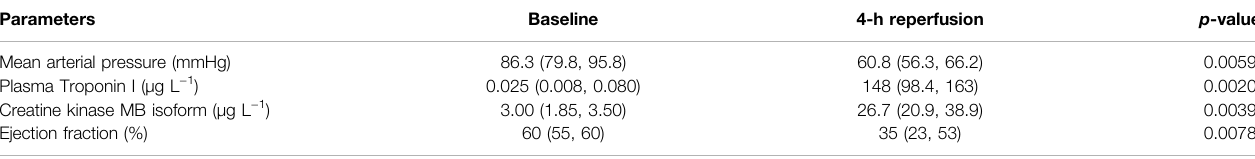
TABLE1| Comparisonofcardiacfunctionparametersatbaselineandafter4 hofreperfusion.Resultsarerepresentedasmedian(25th,75thpercentile)basedonn=10. p ≤ 0.05 (two-tailed) was considered signi fi cant. Parameters